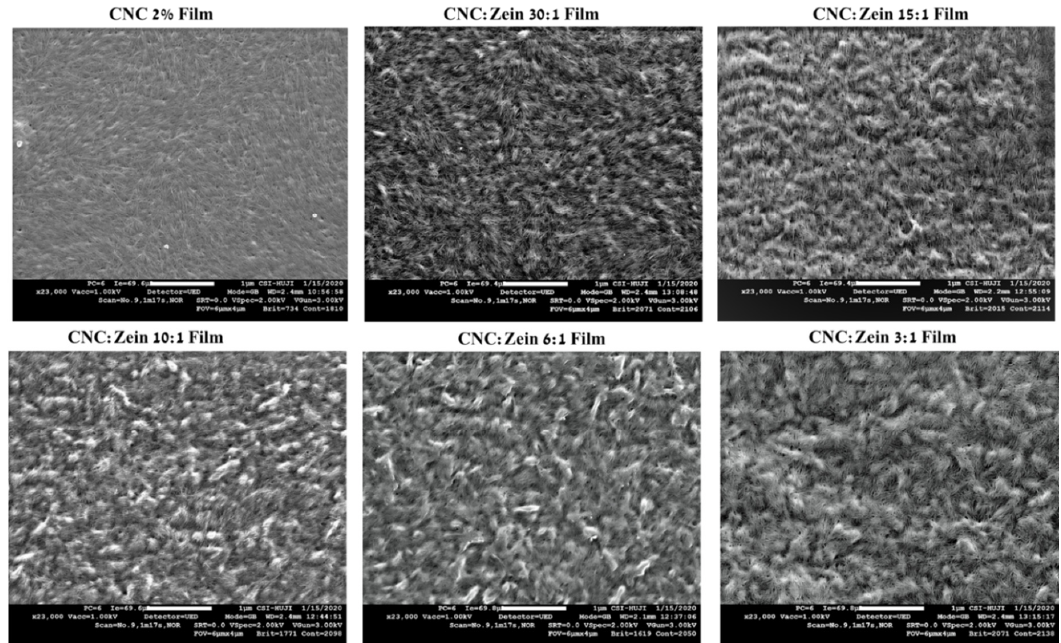
Figure 8. SEM images of non-cross linked CNC and CNC/CZ films. The images are at a magnification of 23,000×.